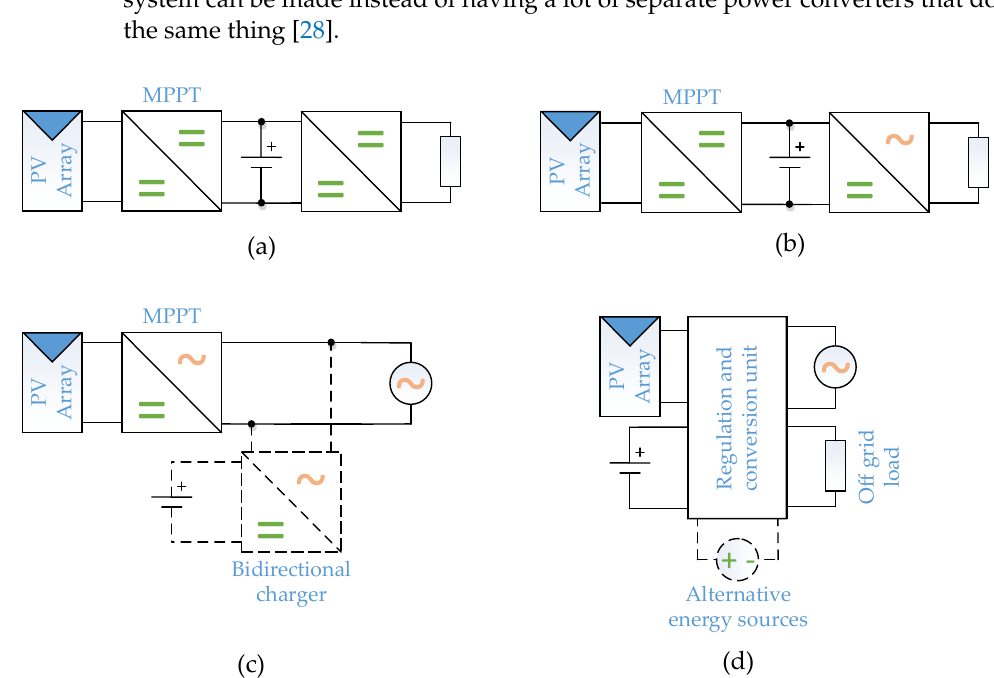
Figure 5. Common PV applications: ( a ) standalone DC systems; ( b ) standalone AC systems; ( c ) on- grid AC systems with energy storage; and ( d ) hybrid systems.